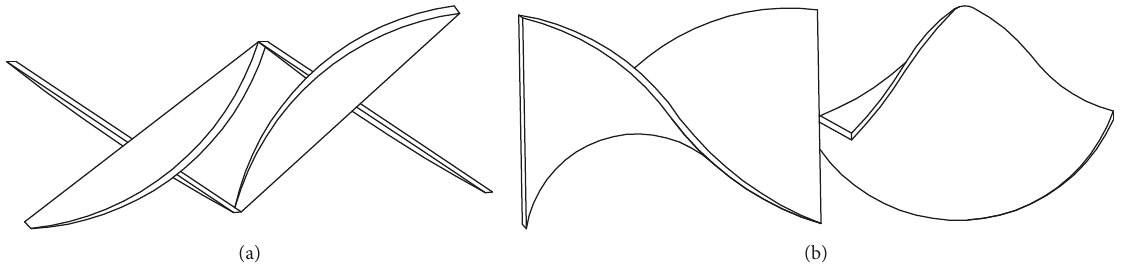
Figure 1: The shape of mixers’ inserts: (a) Koflo static mixer; (b) Kenics static mixer.